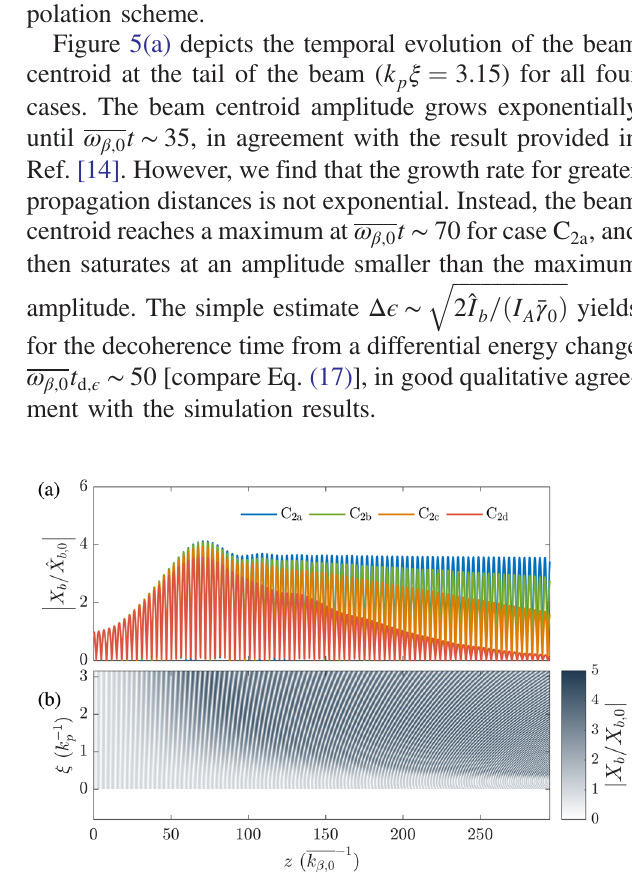
FIG. 5. (a) Evolution of beam centroid at the beam-tails (at k ξ ¼ 4 . 0 ) for cases C p 2 a (blue), C 2 b (green), C 2 c (yellow), and C 2 (red) obtained from PIC simulations. (b) Centroid evolution d along z and ξ for case C 2 , from a PIC a